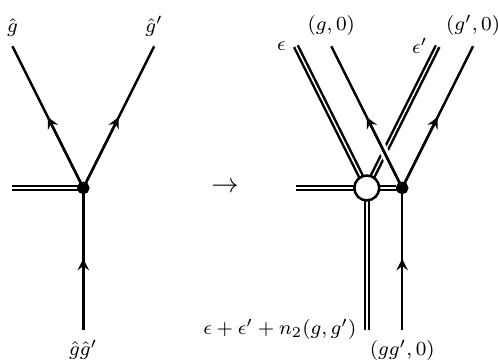
Figure 28 . Gauge (cid:12)xing: we choose basis for various morphisms related in the way shown in the (cid:12)gure.